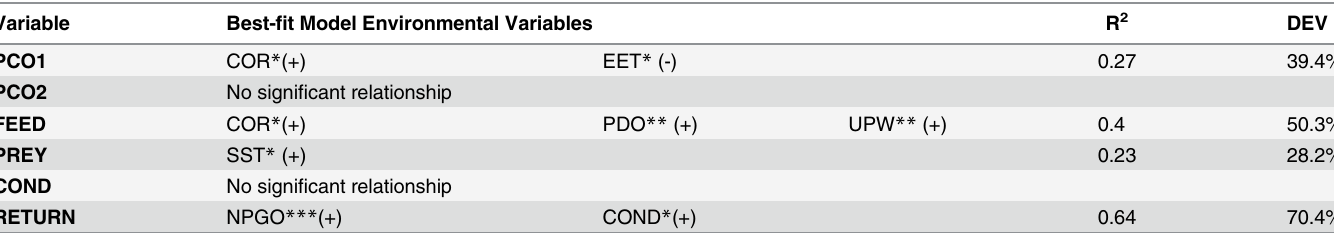
Best- fi t GAM models in June with R 2 and deviance explained (DEV) for the relationships between the fi rst two diet composition PCO axes (PCO1, PCO2), index of stomach fullness (FEED), prey caloric density (PREY), condition (COND), and counts of spring Chinook salmon at Bonneville Dam (RETURN)